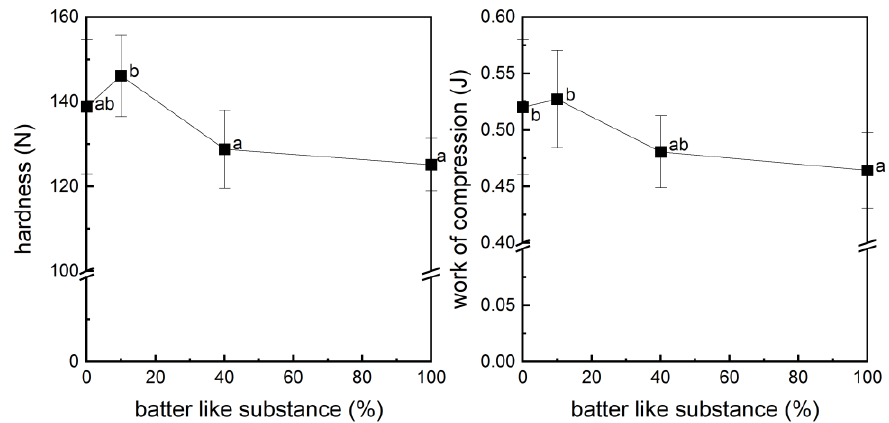
Figure 2. Hardness (N) and total work (J) of the first compression cycle from samples containing 0–100% BLS as determined by a two-cycle compression test to 75% deformation. Superscript letters (a,b) next to datapoints indicate significant differences according to a Tukey test ( p < 0.05).